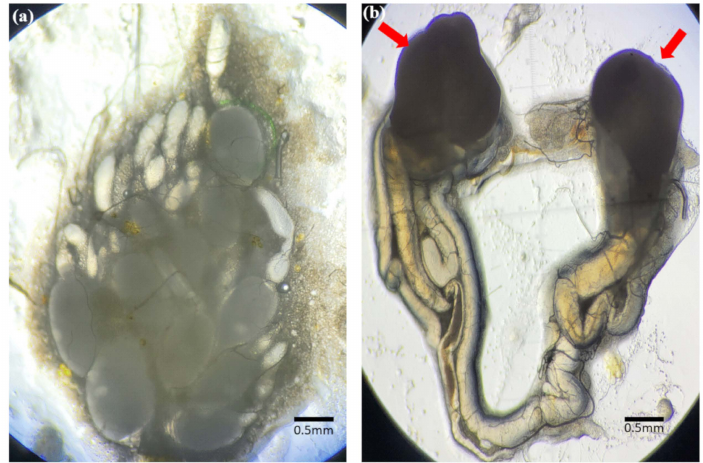
Figure 6. Reproductive organs isolated from female and male adult mealworms. ( a ) Various ovarioles at different developmental stages were observed in the female adult mealworm, and ( b ) two testes (red arrow) in the male adult mealworm.